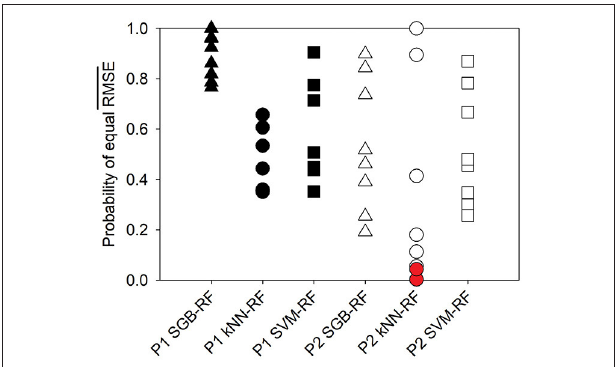
FIGURE 1 | Probabilities for the mean RMSE value to be the same in the RF and other ML applications based on the corrected t-statistic. Symbols in red show statistical